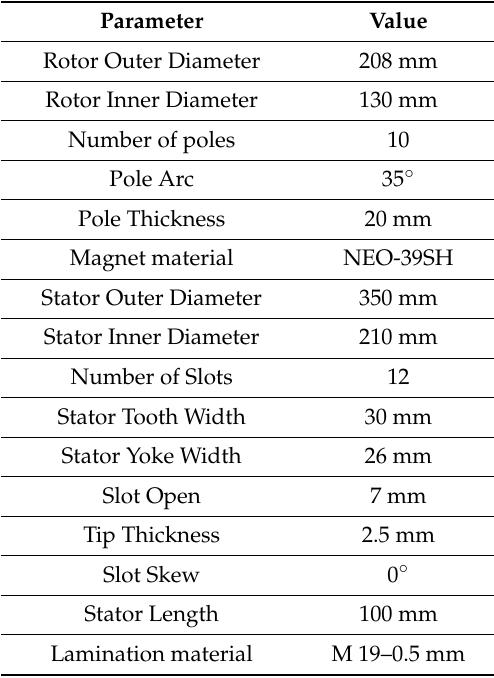
Figure 4. The cross ‐ sections of the studied motor. ( a ) with the uniform rotor; ( b ) uniform rotor, ( c ) with the optimal rotor, ( d ) optimal rotor. Table 1. The specification of the investigated motors.